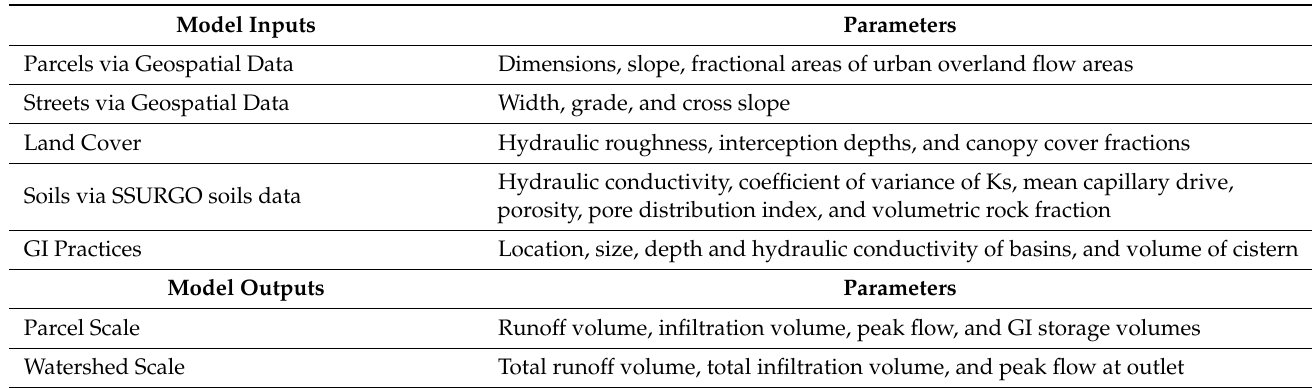
Table 1. Summary of KINEROS2 model inputs and outputs.